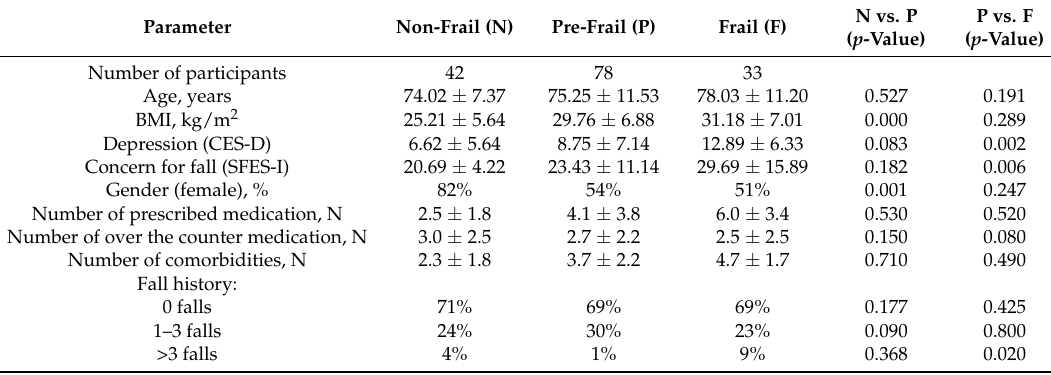
Table 1. Demographic and clinical characteristics reported by mean ± standard deviation.